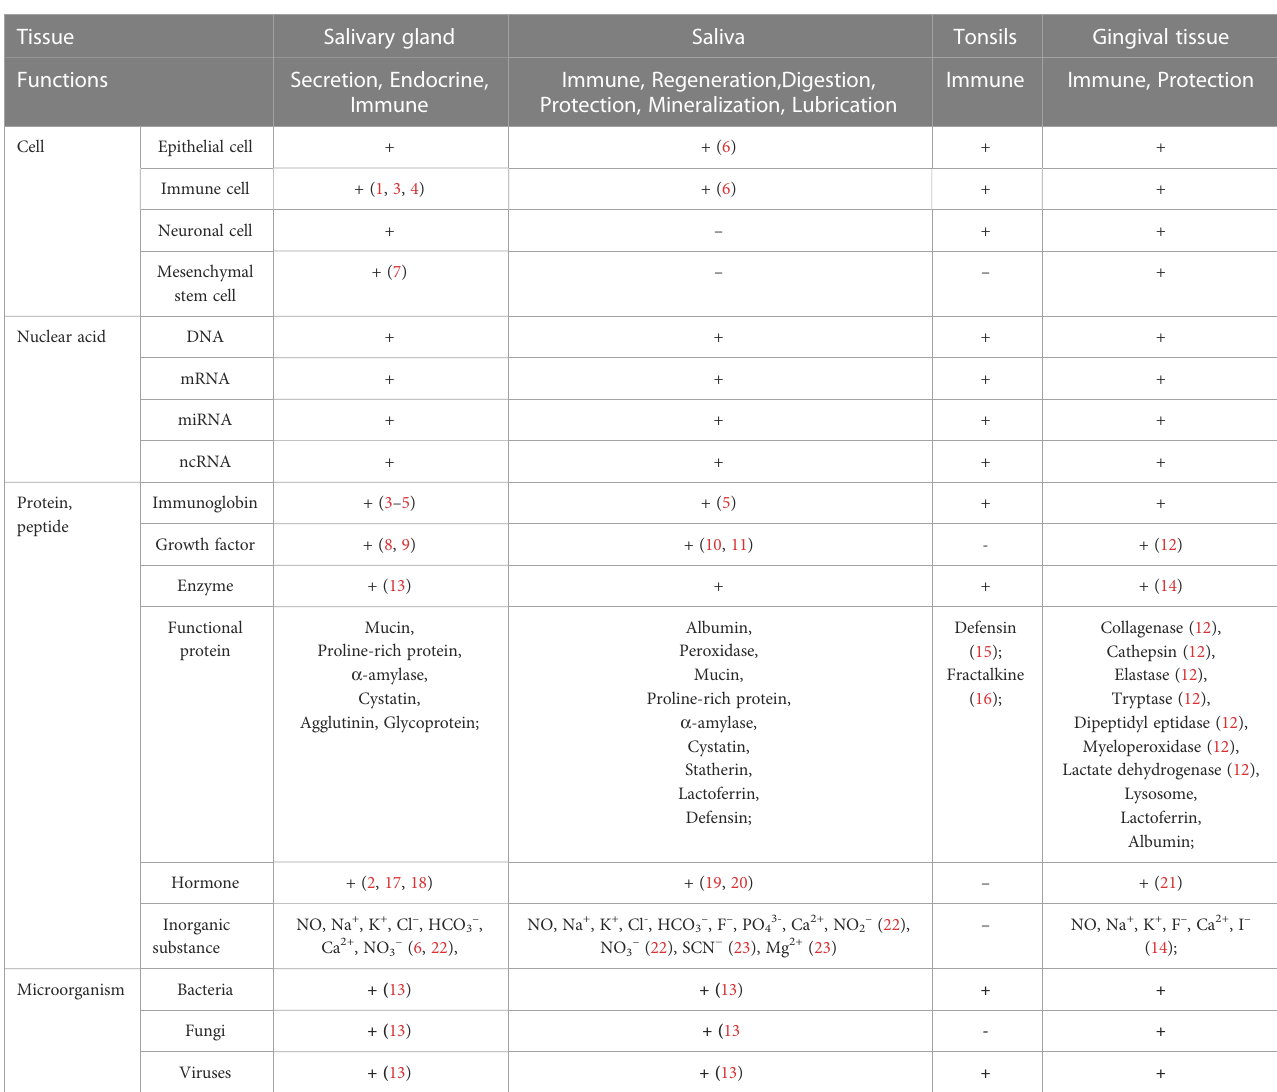
TABLE 1 Cells, molecules, and microorganisms in oral tissue and saliva. Tissue Salivary gland